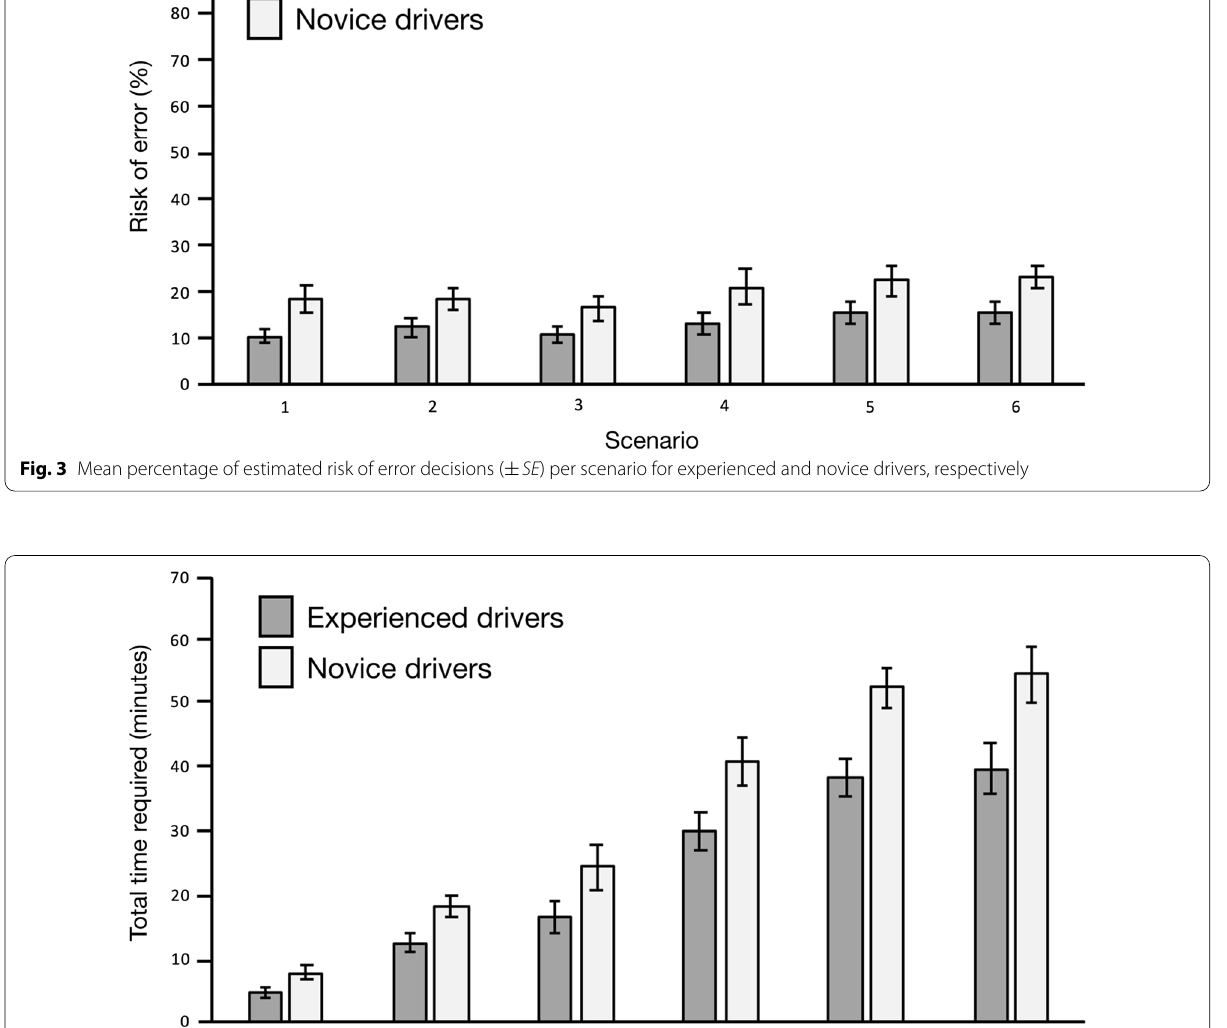
SE ) for experienced and novice drivers, ±